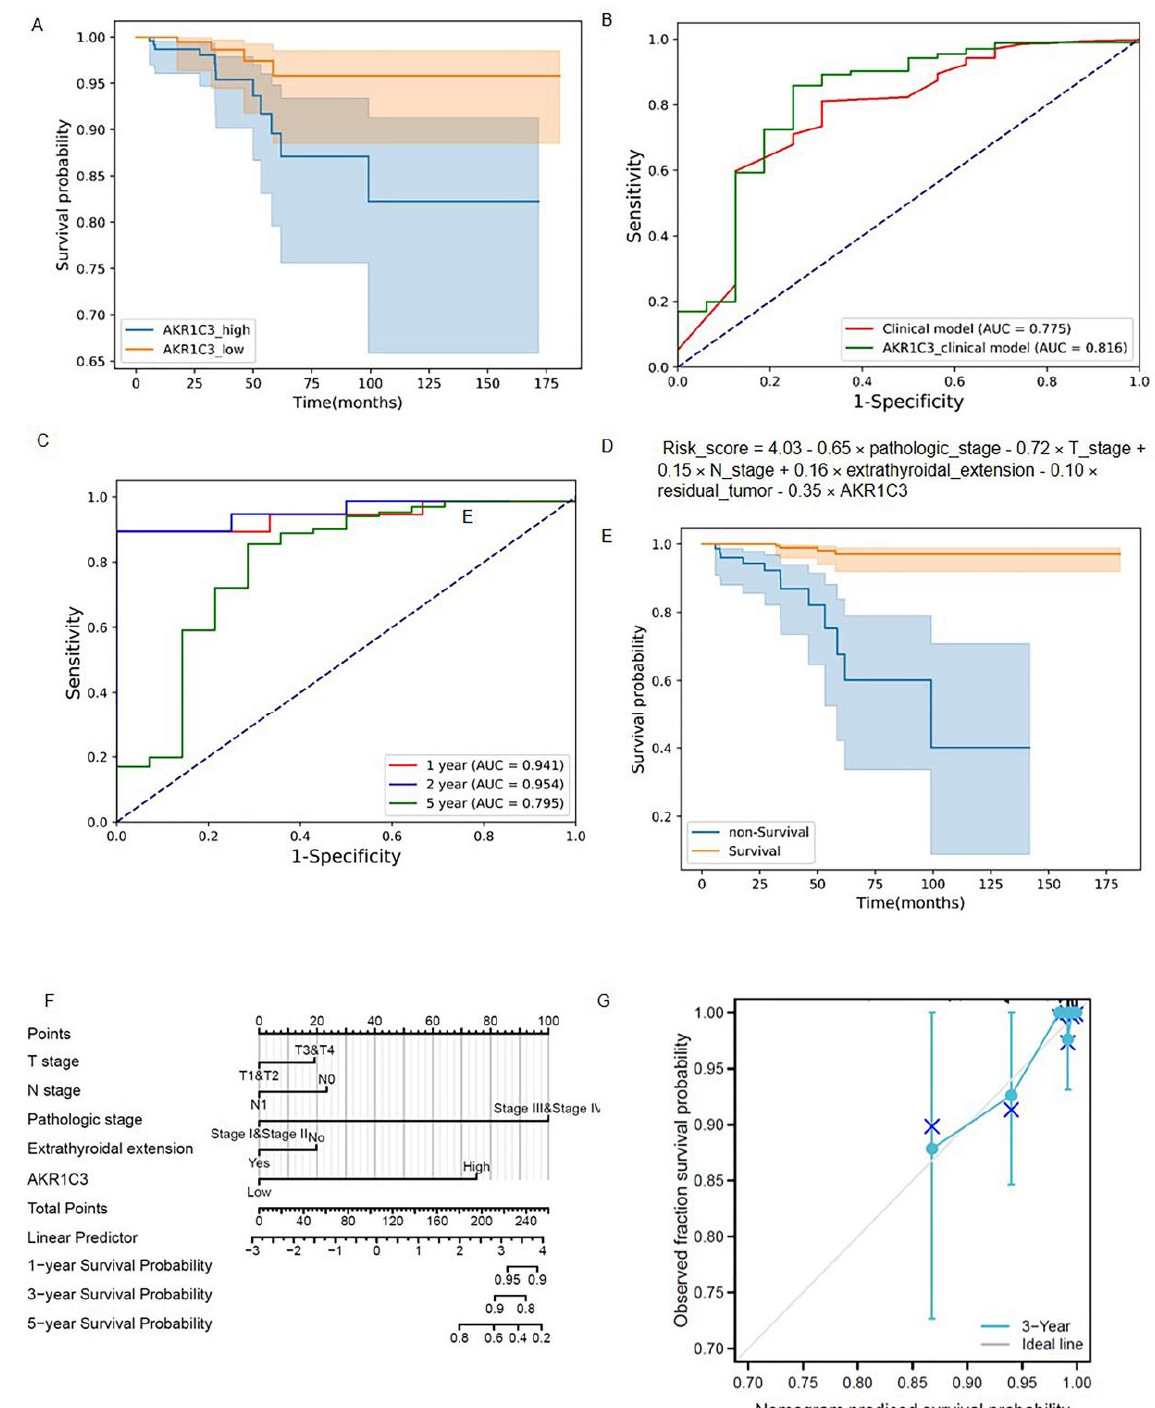
Figure 3. The predictive model construction. ( A ) Kaplan–Meier survival curves of the AKR1C3_high group and AKR1C3_low group; ( B ) ROC curves of the AKR1C3_clinical model and clinical model; ( C ) ROC curves of the AKR1C3_clinical model and clinical model at one, two, and five years; ( D ) risk score of the AKR1C3_clinical model; ( E ) Kapla–Meier survival curves of the predictive survival group and predictive non-survival group using the AKR1C3_clinical model; ( F ) Proposed nomogram to predict 1-,3-, and 5- OS for THCAe; ( G ) calibration curve for the probability of the 3-year OS.